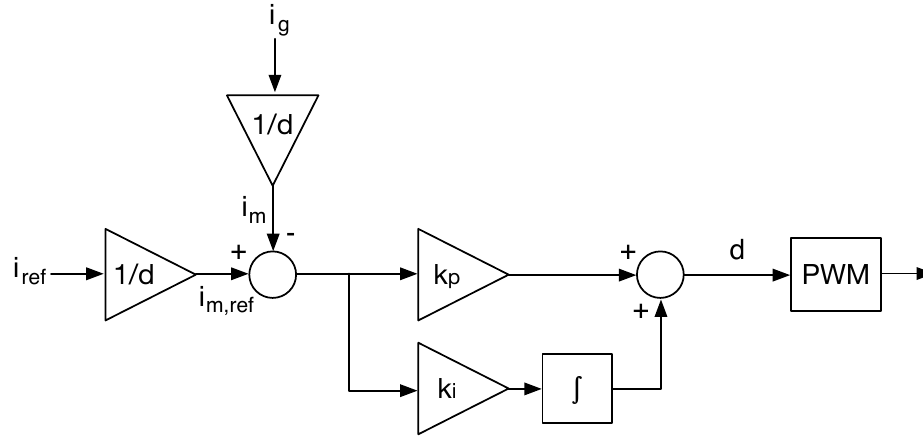
Figure 7. Block diagram of the current